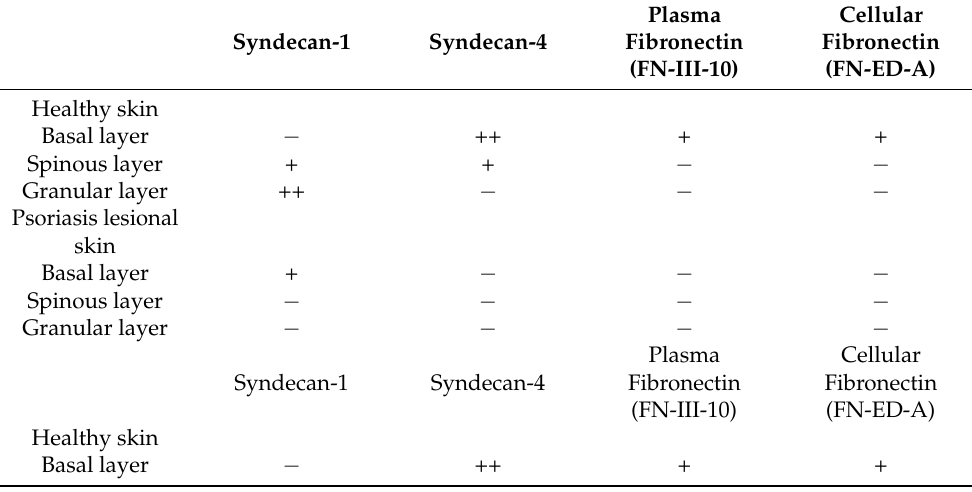
Table 1. Quantification of staining in the histological